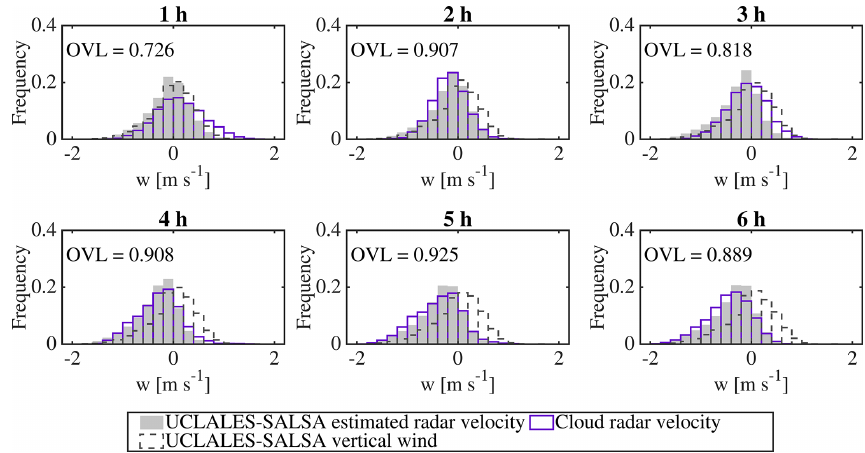
Figure 16. Comparison of distributions of radar velocity retrieved from cloud radar observations at in-cloud conditions to those calculated by UCLALES–SALSA for case 2 of 31 October 2020 in the simulation scenario with 40% reduction in aerosol loading used for model initialization with ice formation. Overlapping index values (OVLs) are included as indicators of agreement between